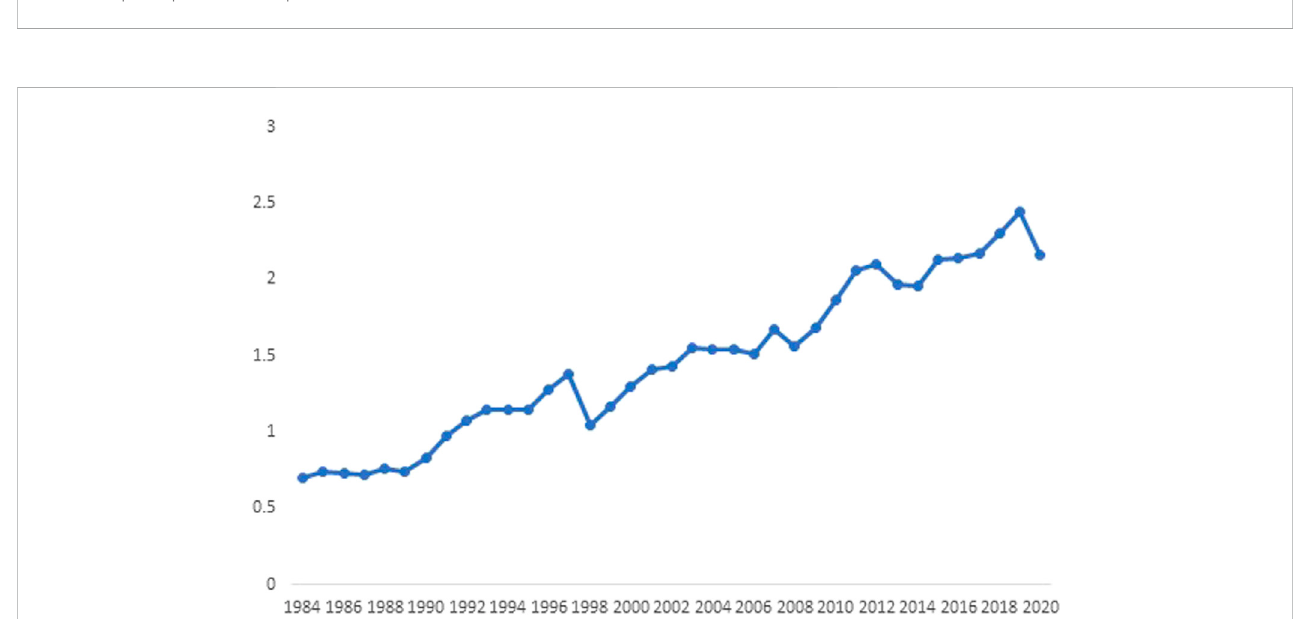
FIGURE 2 Trend of CO 2 emission in Indonesia, 1984 – 2020 (metrics per capita